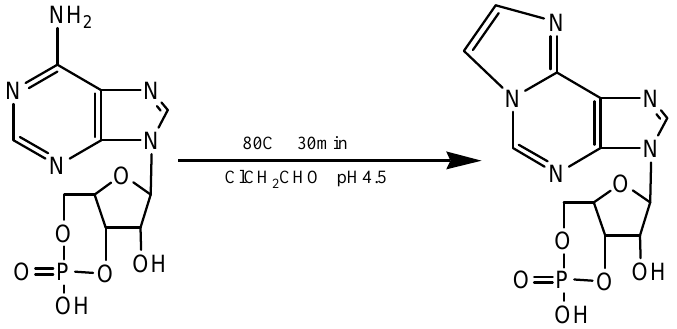
Figure 1. Derivatization reaction of cAMP by 2-chloroacetaldehyde.